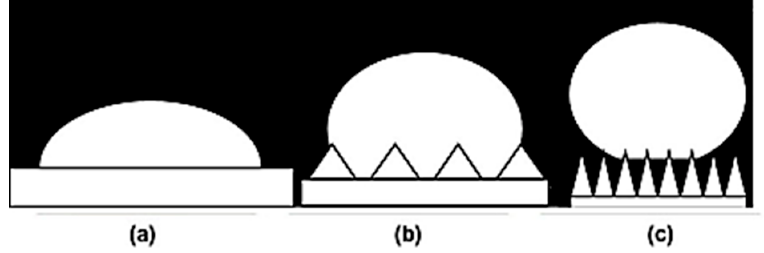
Figure 4. Representation of the Young ( a ), Wenzel ( b ) and Cassie-Baxter ( c ) models showing the main differences in terms of surface and interactions with the droplet.